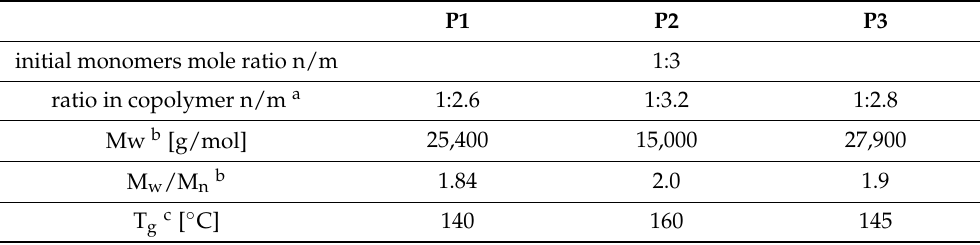
Table 1. Characteristics of copolymers containing styrylquinoline units. P1 P2 P3 initial monomers mole ratio n/m